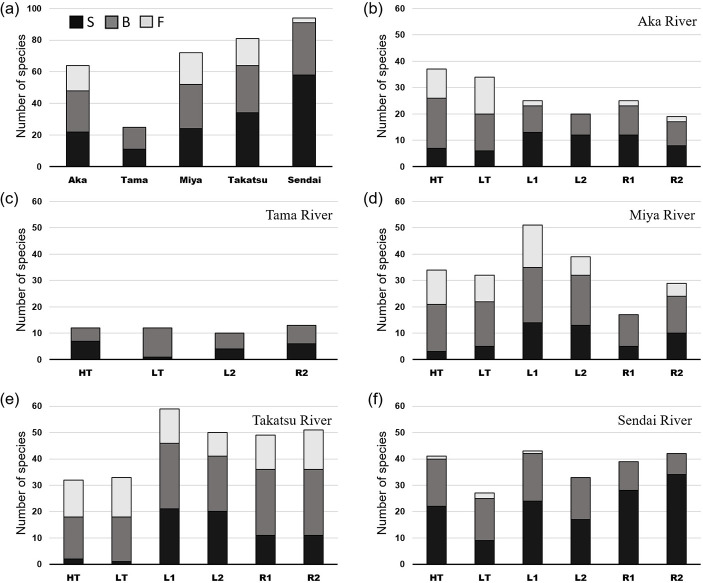
Species richness.Number of species present in (a) all five rivers and at each station, (b) Aka River, (c) Tama River, (d) Miya River, (e) Takatsu River, and (f) Sendai River. HT: river mouth at high tide; LT: river mouth at low tide; L1: left 500 m; L2: left 1 km; R1: right 500 m; R2: right 1 km; S: seawater species; B: brackish water species having a wide range of salinity tolerance including migrating fishes; F: freshwater species.